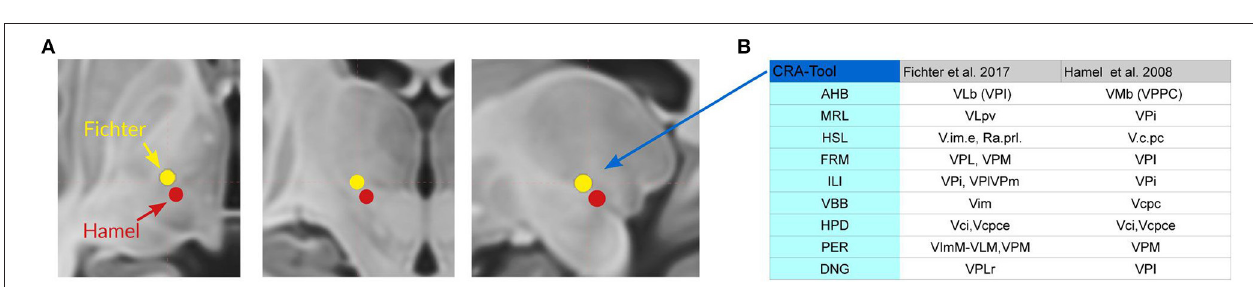
FIGURE 11 | Visualization of W max (top row) and W asym (bottom row) in 3D space. The regions with high concordances and asymmetry (MD, AV) can directly be identified in the slices as areas with strong red color. The ellipsoid and arrows point to the region with the lowest concordances: lateral ventroanterior nucleus (VAL) and intralaminar formation (IL).